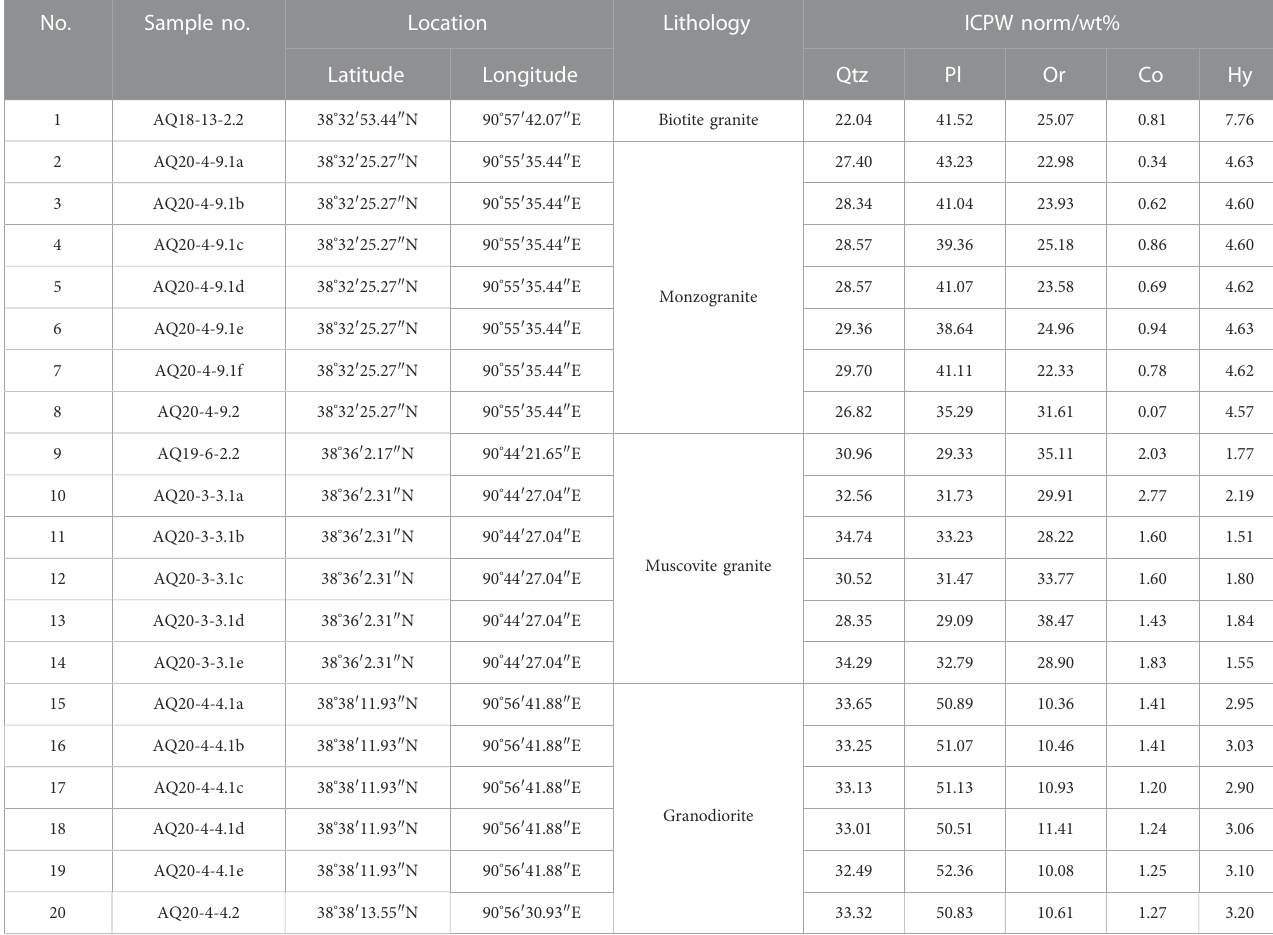
TABLE 1 Sampling location, ICPW norm calculation, and analytic items for granitoids from the western Qaidam block. No. Sample